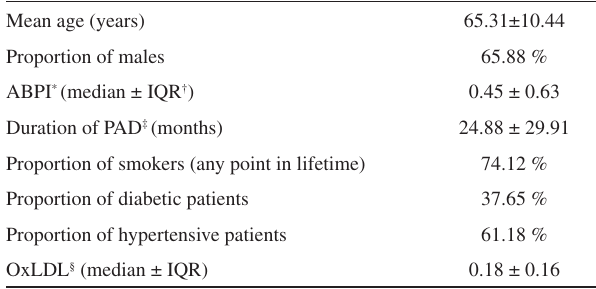
Table 1 - Demographic data of the sample population.